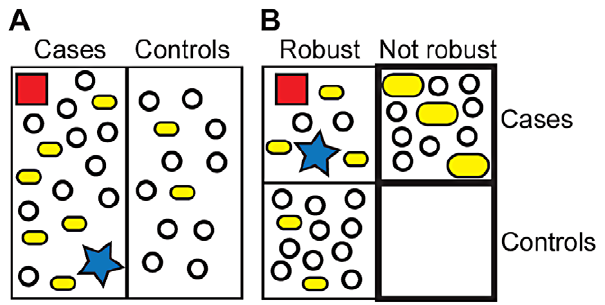
Figure 2. Current and suggested GWAS approaches. (A) Current approach. GWAS identify variants that are overrepresented in cases. Rare variants of large effect (red square, blue star) may escape detection, thereby contributing to missing heritability. Common variants that are overrepresented in cases (small yellow bar, 6 versus 2) do not contribute strongly to disease risk. A cryptic disease-related variant does not show significant overrepresentation in cases (open circle). (B) Suggested approach. Individuals are first analyzed for phenotypic robustness (bold box) and then for variants associated with disease. Rare variants of large effect will be enriched in robust cases, although they may also be present in nonrobust cases. Variants that are overrepresented in all cases (robust, nonrobust) will show higher penetrance in nonrobust individuals (large yellow bars). The formerly cryptic, disease-related variant (open circle) is significantly enriched in nonrobust cases versus nonrobust controls (and robust cases) and can therefore be identified. Together, heritability signifi- cantly increases. The formerly cryptic genetic variant and higher penetrance variant can be thought of as ‘‘disease-specifiers’’ as they determine the specific disease phenotype of individuals carrying them. Note symbols represent highly simplified frequencies of specific variant in indicated groups and not individuals carrying certain variants.